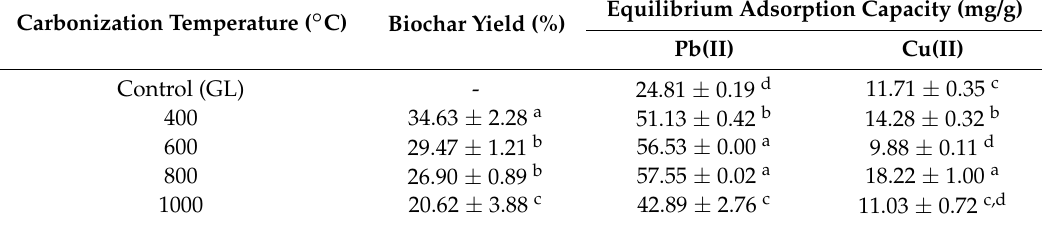
Table 3. Biochar yield and heavy metal adsorption capacities according to carbonization temperature. Data are the means ± standard deviation. Means with the same letter in a column do not significantly differ at p < 0.05, as determined by Duncan’s multiple range test with SPSS version 24 (IBM, Armonk, NY, USA). The high mean to low mean sequence is marked by the letters a to d .